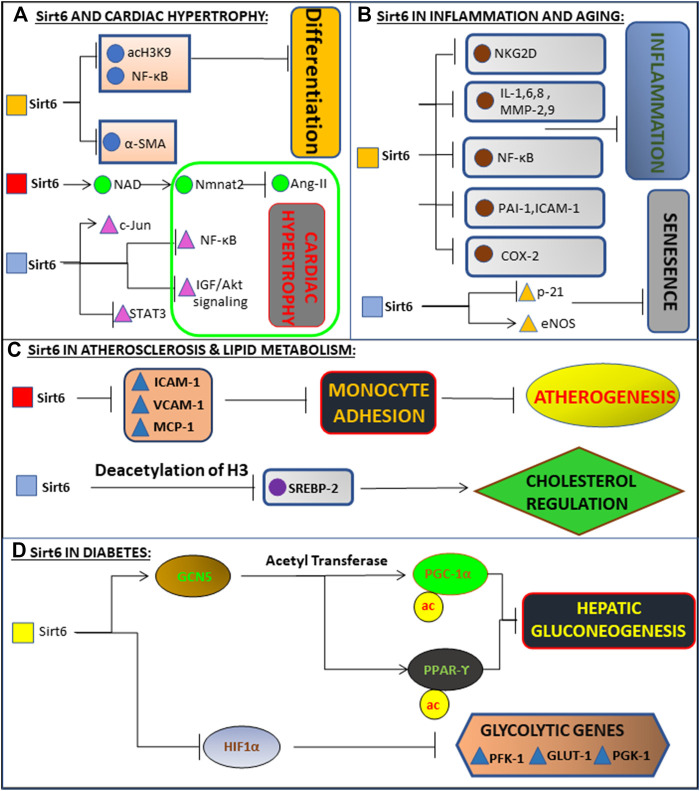
Modulators of Sirt6.